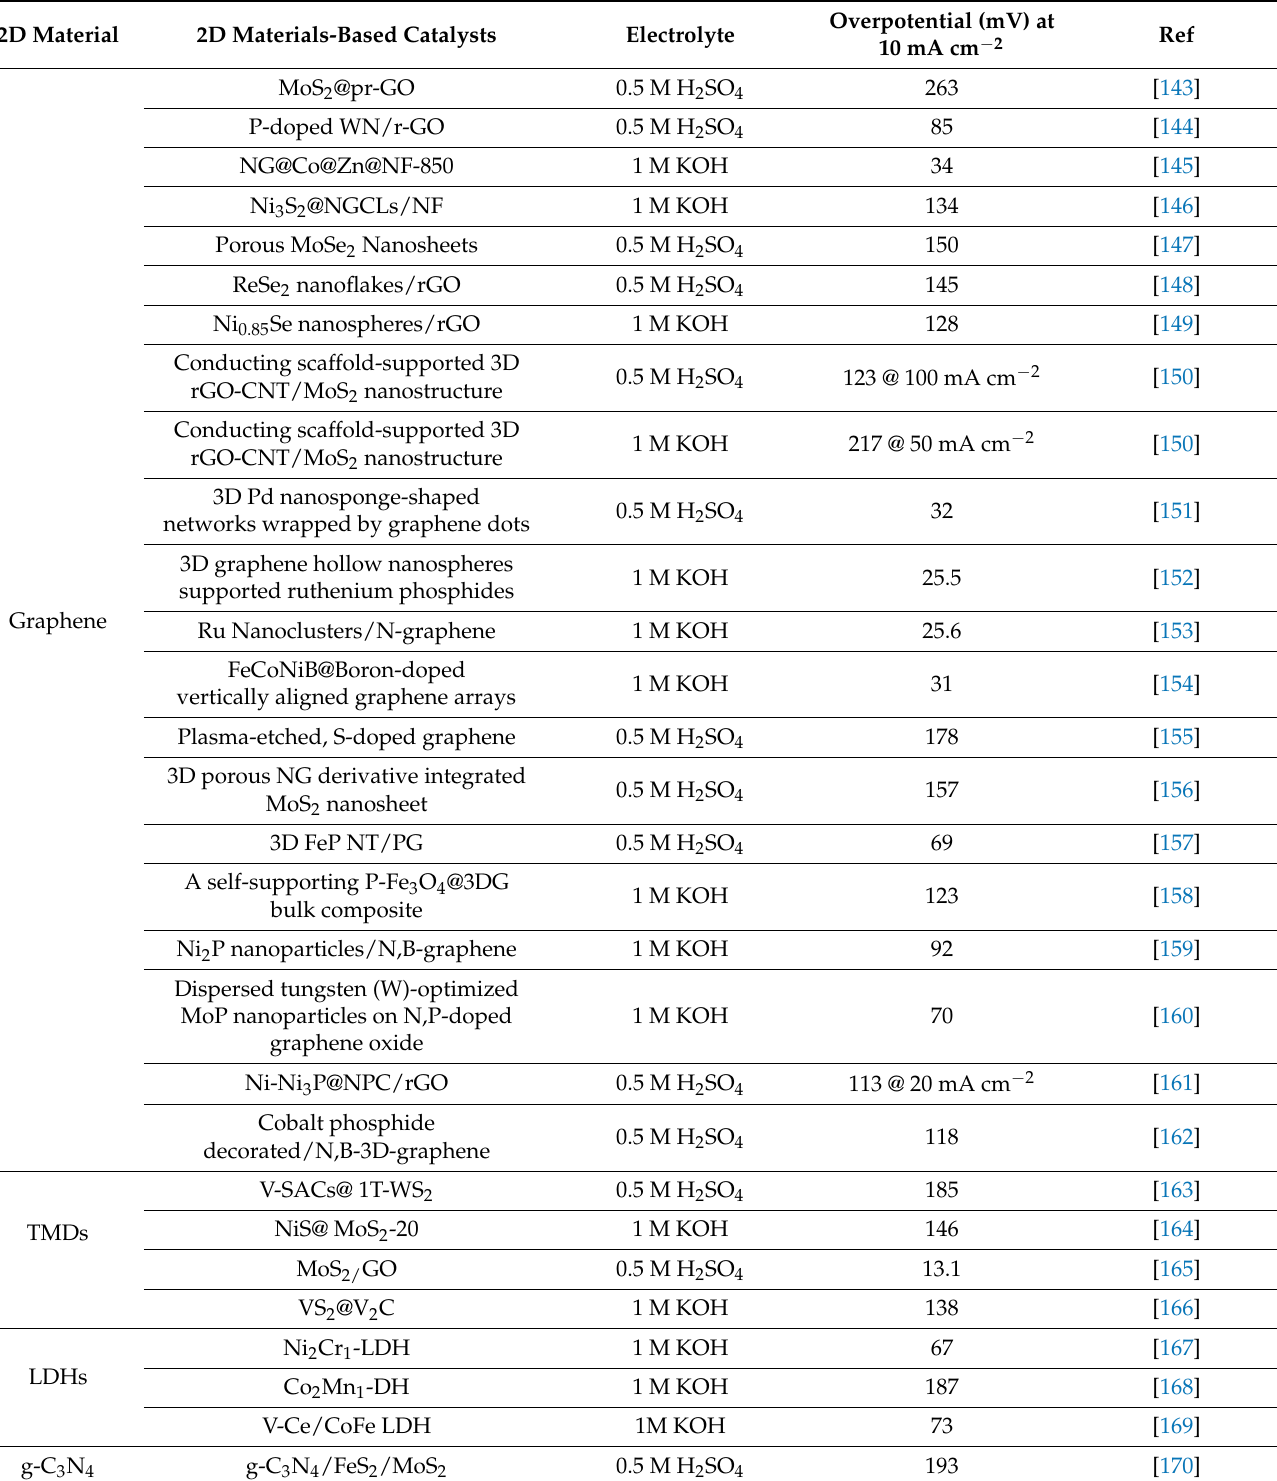
Table 3. Comparison of MXenes HER performance with the other 2D-layered non-precious-based electrocatalysts in acidic and alkaline